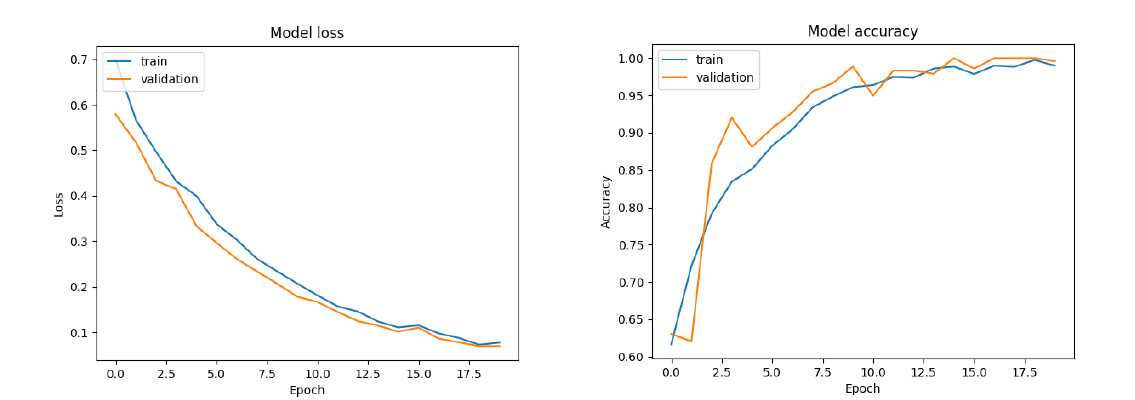
Figure 17. Train/Val loss and accuracy of the hybrid classifier, over 20